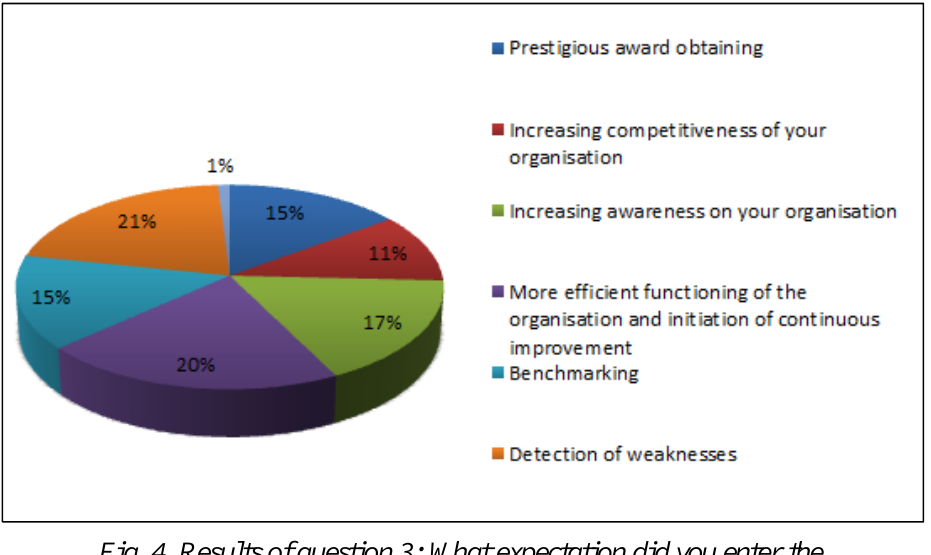
Fig. 4 Results of question 3: What expectation did you enter the competition